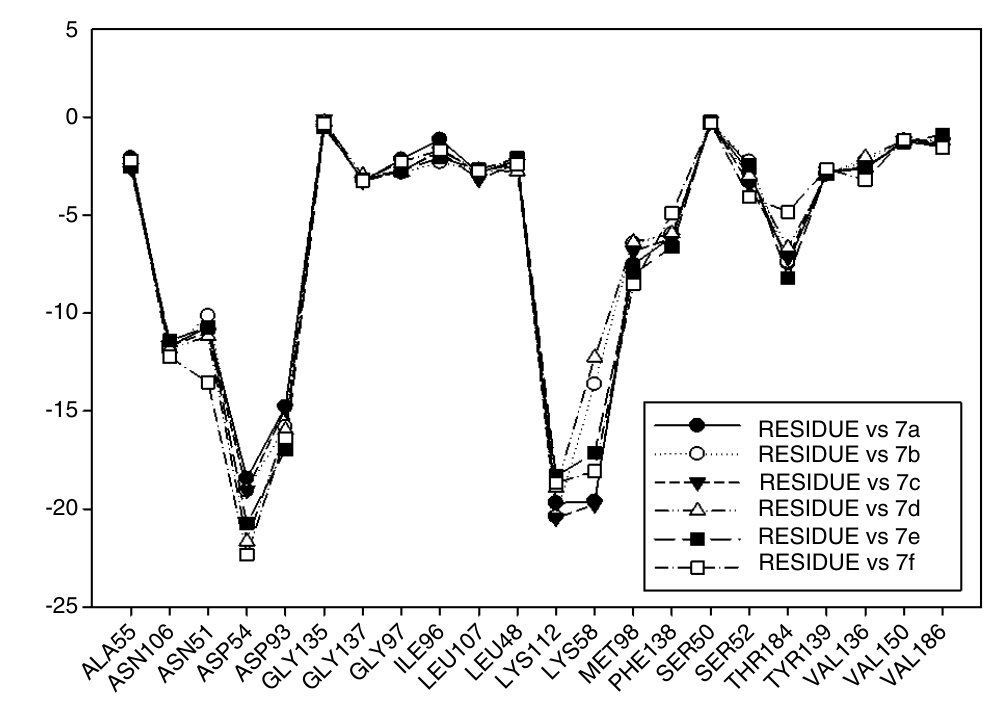
Figure 14. Interaction energies of 11-amine geldanamycin analogues.